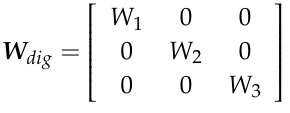
Table 1. The tendency of distance error with the desired FFP position by increasing the number of point utilized in a weighted-norm solution.